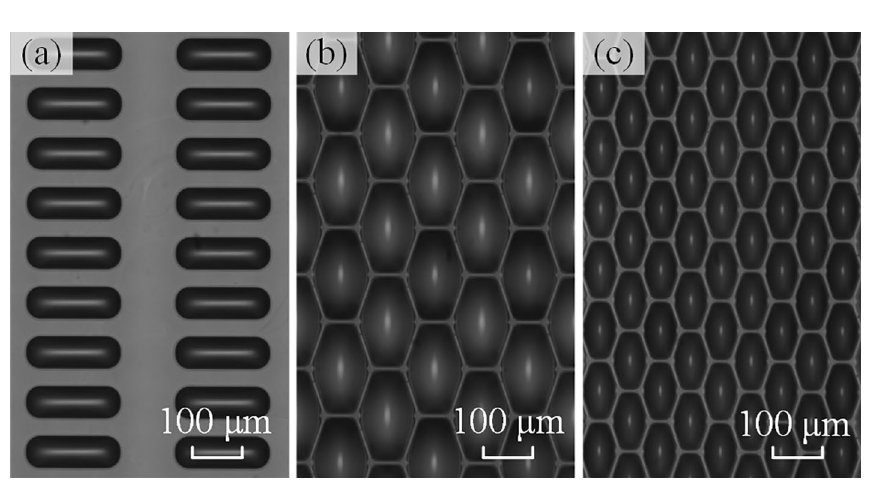
Figure 11. Printing results for panels with different pixel densities. ( a ) 85 PPI. ( b ) 144 PPI. ( c ) 200